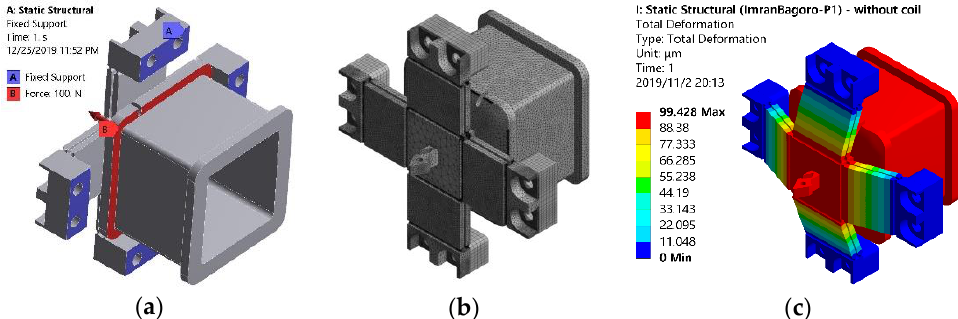
Figure 5 . Static structural analysis of the flexure mechanism, ( a ) the constraint, ( b ) the meshed model, and ( c ) the resultant deformation with F = 100 N.